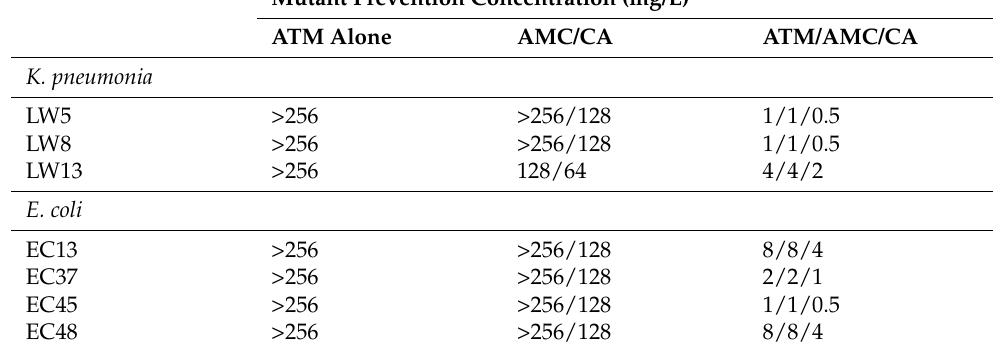
Table 3. Mutant prevention concentrations (MPC) of aztreonam (ATM), amoxicillin/clavulanate (AMC/CA, 2:1 ratio) and aztreonam/amoxicillin/clavulanate (ATM/AMC/CA) against seven K. pneumonia and E. coli